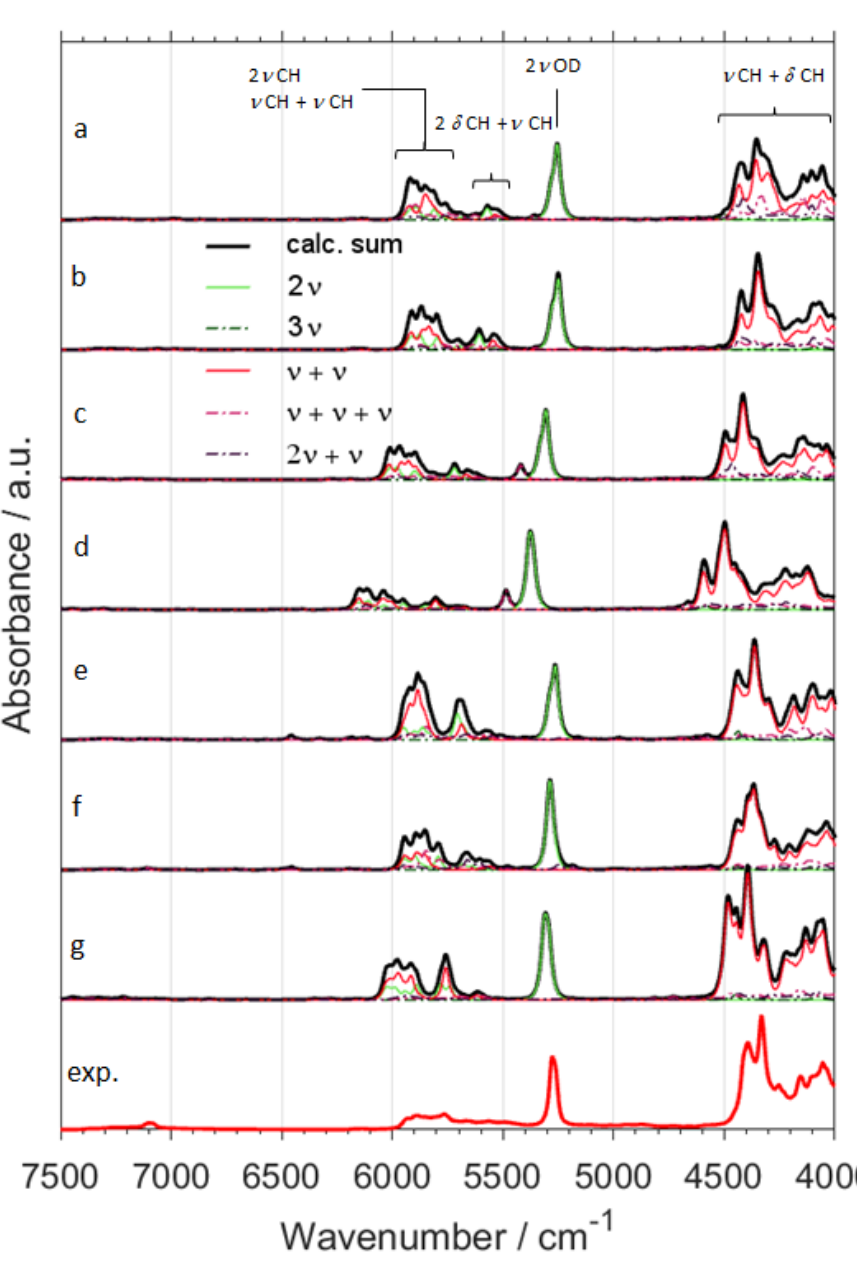
Figure 2. NIR spectra of CH 3 CH 2 OD calculated with GVPT2 method at different levels of electronic theory; ( a ) B3LYP-GD3BJ / 6-31G(d,p); ( b ) B3LYP-GD3BJ / 6-31G(d,p) // CPCM; ( c ) B2PLYP-GD3BJ / 6-31G(d,p) // CPCM; ( d ) MP2 / 6-31G(d,p) // CPCM; ( e ) B3LYP-GD3BJ / SNST // CPCM; ( f ) B2PLYP-GD3BJ / def2-TZVP // CPCM; ( g ) MP2 / aug-cc-pVTZ // CPCM; ( exp. ) Experimental spectrum of CH 3 CH 2 OD in CCl 4 (0.1 M).